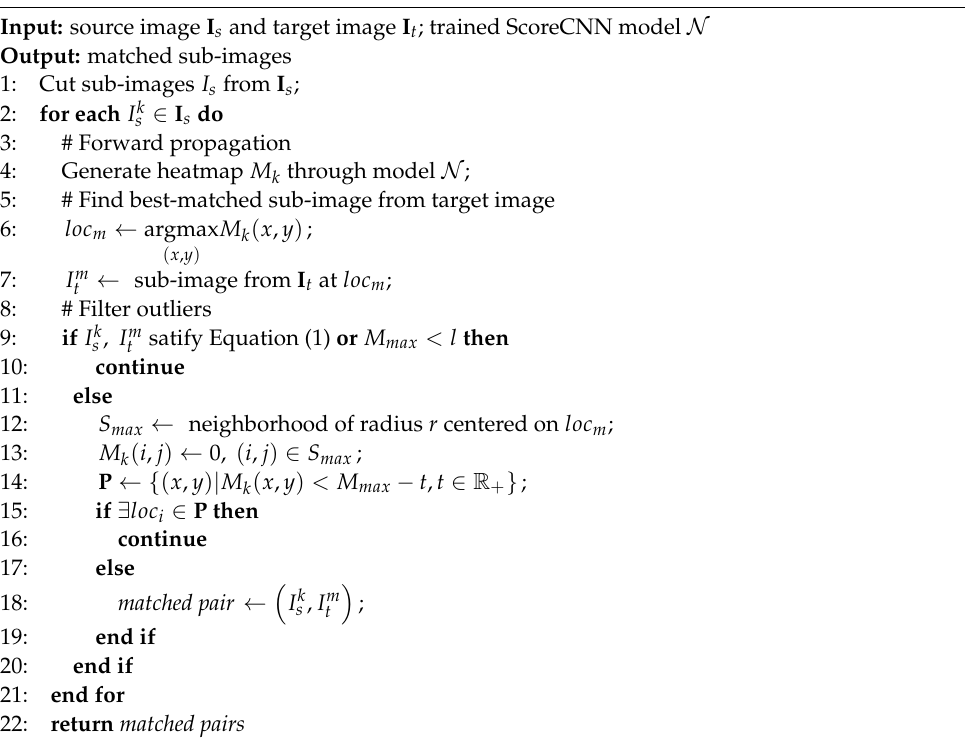
Algorithm 1 Matching of